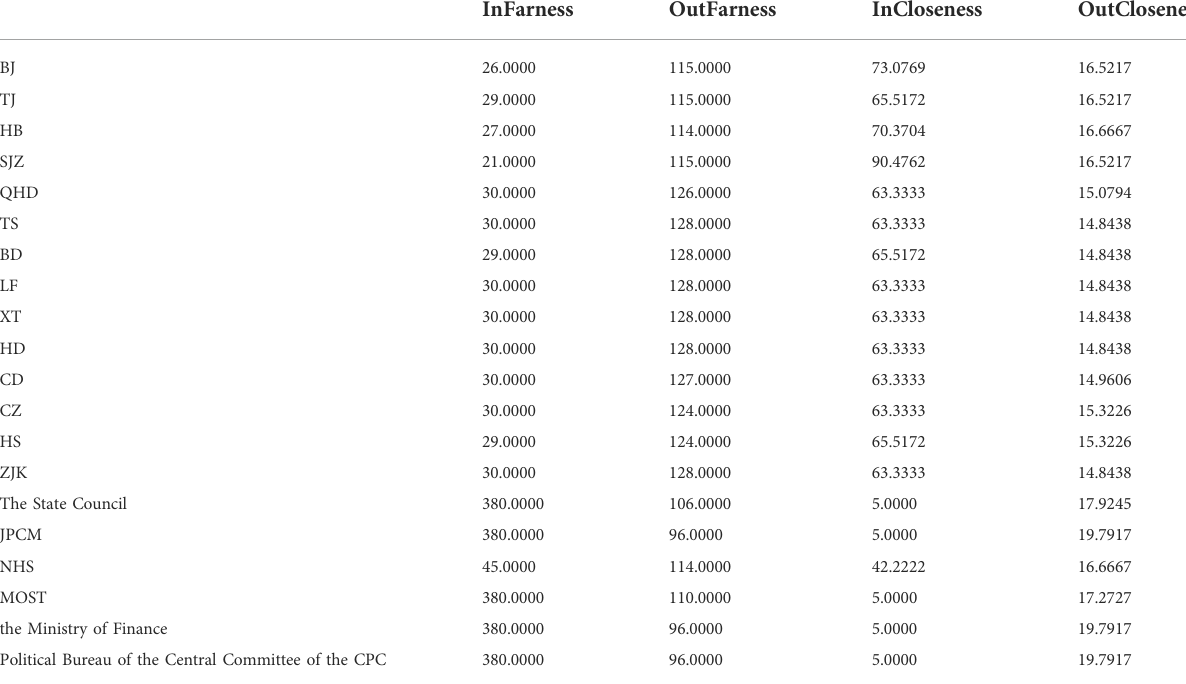
TABLE 5 Closeness centrality analysis of the ECSNs for COVID-19 in the B-T-H